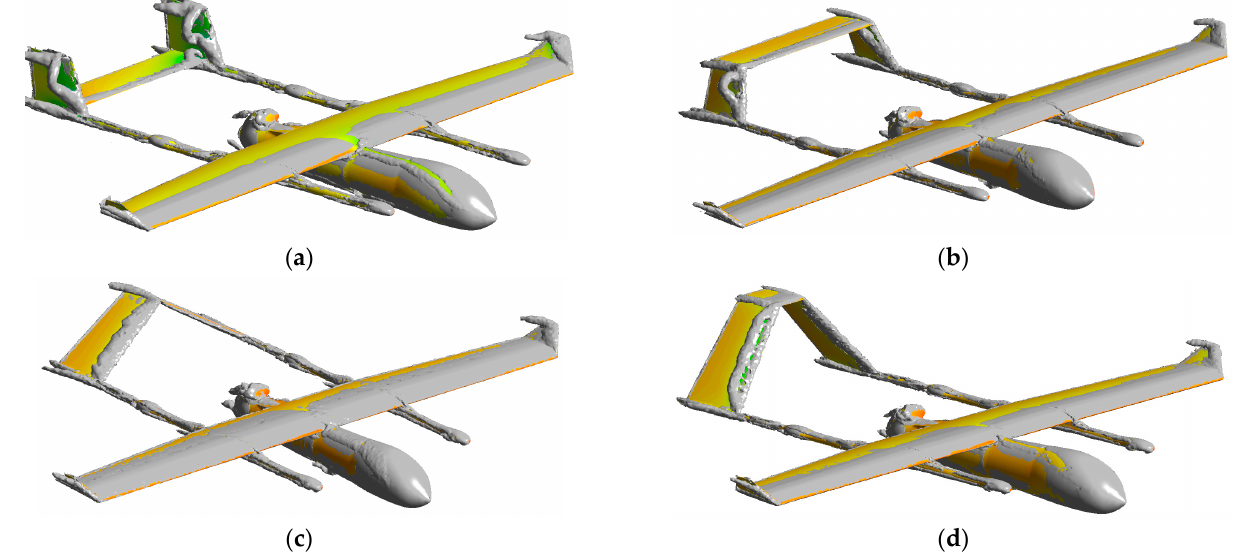
Figure 16. Vortex of the aircraft on a sideslip angle of 30° and AoA of 5°; ( a ) U-shaped boom, ( b ) Inverted U-shaped boom, ( c ) inverted V-tail boom, and ( d ) semi-inverted V-tail boom.